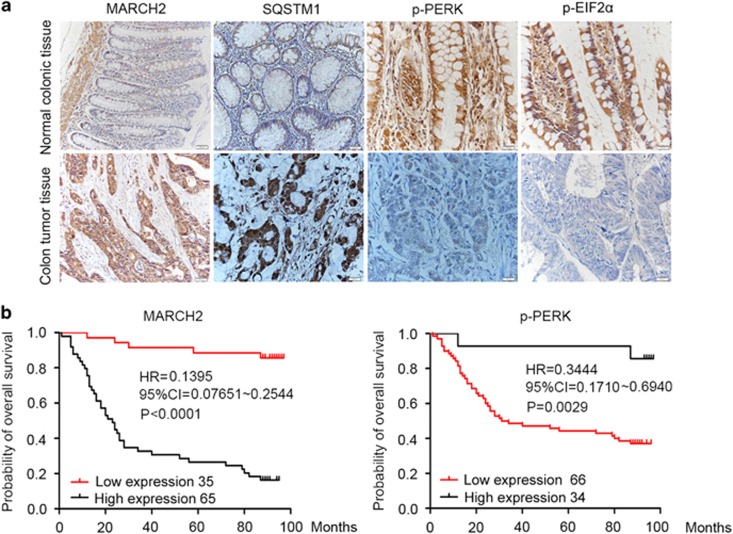
MARCH2 is upregulated in human colon cancer. (a) immunohistochemical staining for MARCH2, SQSTM1, p-PERK (Thr 981) and p-EIF2α (Ser 51) in human colon cancer tissues and adjacent non-tumor colon tissues. (b) Kaplan–Meier survival analysis the correlation between the levels of MARCH2 (or p-PERK) and the survival time in colon cancer patients